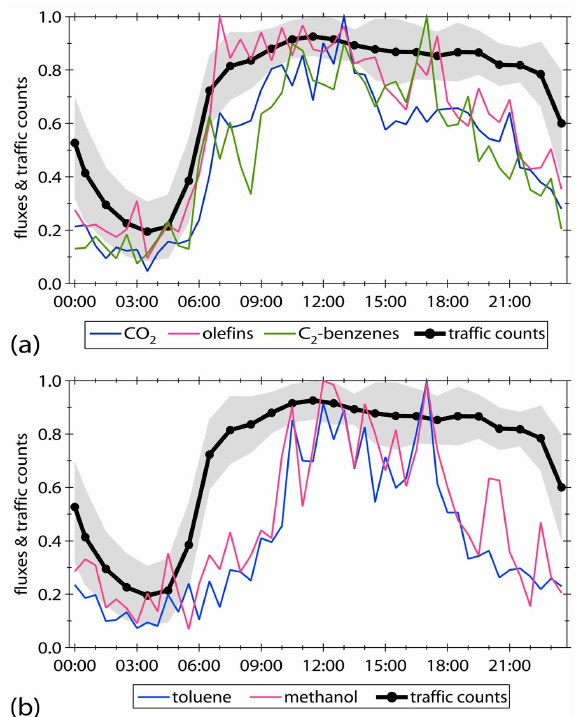
Fig. 7. Diurnal profiles of normalized traffic counts and fluxes of CO 2 , olefins, and C 2 -benzenes (a) , and toluene and methanol (b) . The traffic counts represent the average traffic from 11 roadways in a 10km radius from the flux tower site. The gray shadow indi- cates ± 1 standard deviation from the traffic counts. The time scale corresponds to the local standard